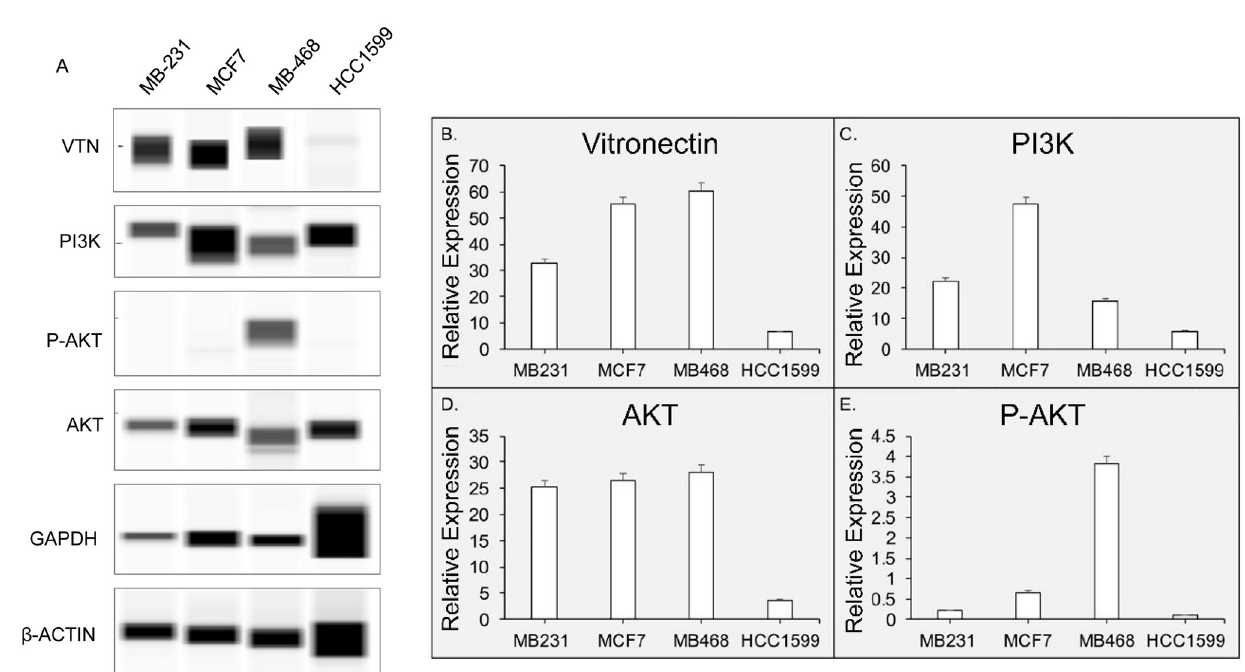
Fig 5. Vitronectin expression is modulated by PI3K/AKT axis. A . Displays the pseudo blot extracted from SimpleWestern experiments. There are four cell-lines- MDA-MB-231, MCF7, MDA-MB-468, HCC1599, were used to evaluate the signaling cascade relationship. Different protein expression levels were normalized with an averaged house-keeping GAPDH and β -actin expression B . Compares vitronectin concentration levels in four BC cell lines. C . PI3K concentration levels in BC same cell-lines. D . compares AKT concentration and, E . P-AKT concentration levels in the same four BC cell lines.